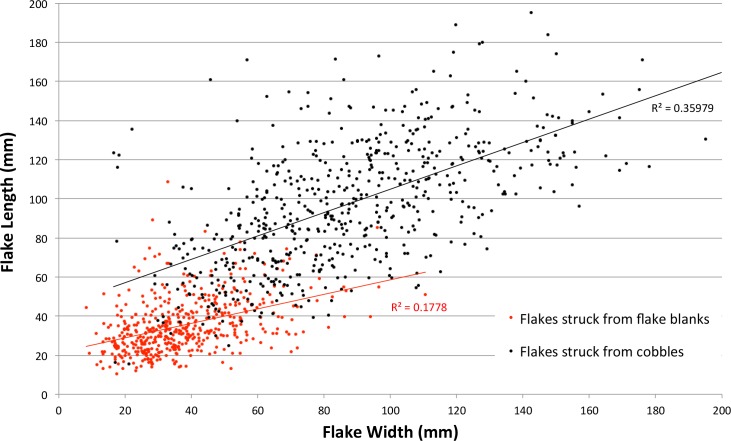
Scatterplot of flake lengths and widths produced in the cobble and flake blank reduction experiments.